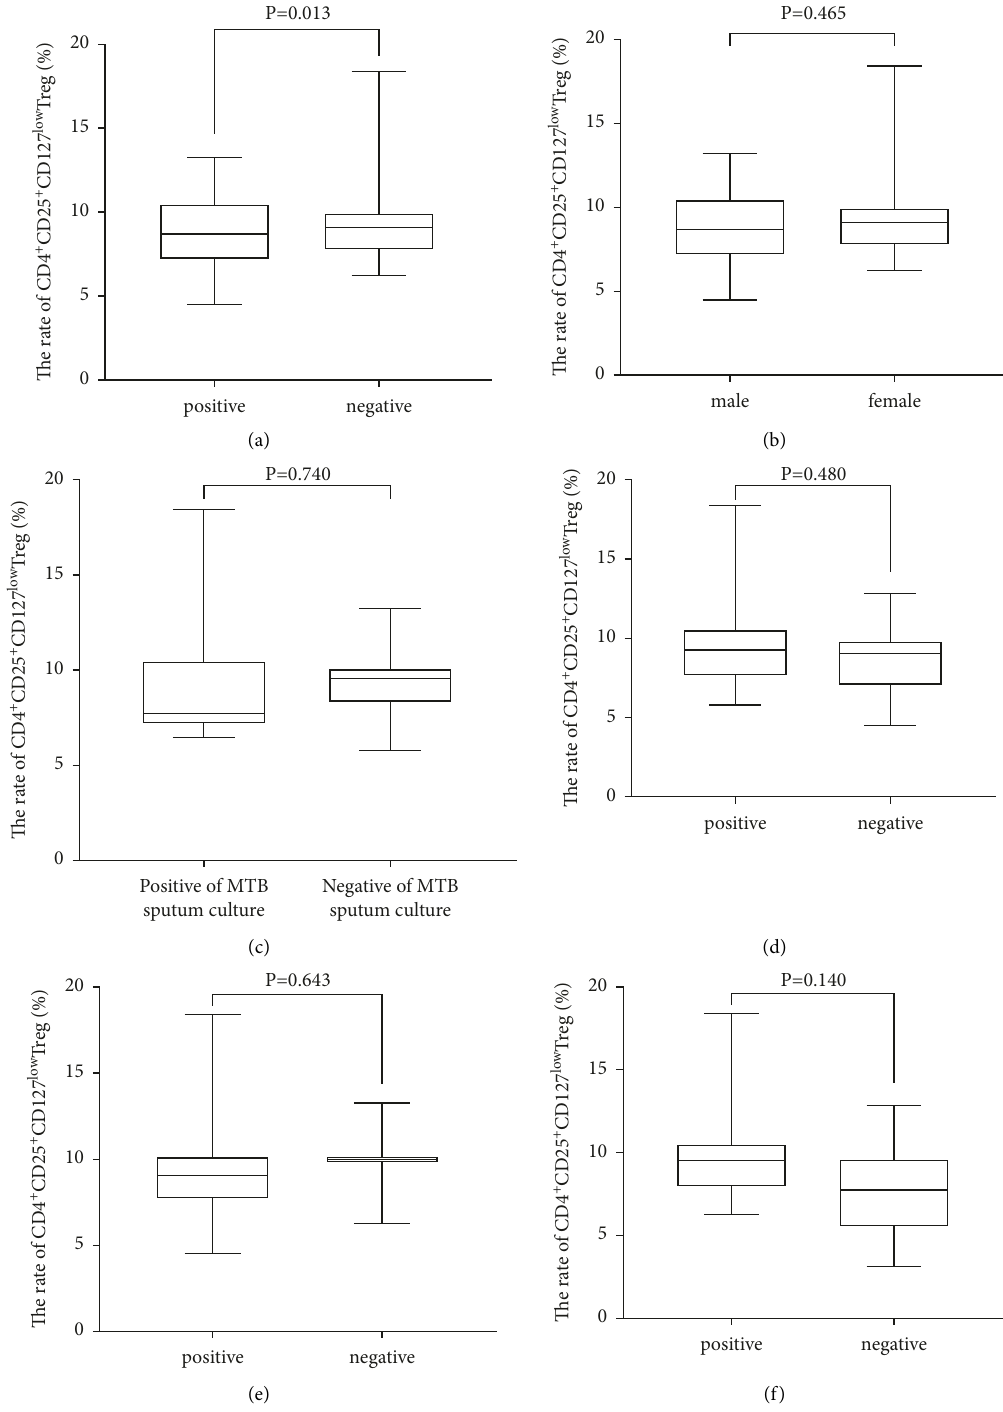
Figure 2: Proportions of peripheral blood CD4 + CD25 + CD127 low Tregs among active pulmonary tuberculosis patients with different demographic and clinical characteristics. (a) Comparison of the proportion of peripheral blood CD4 + CD25 + CD127 low Tregs between active pulmonary tuberculosis patients with positive and negative anti- M. tuberculosis antibodies. (b) Comparison of the proportion of peripheral blood CD4 + CD25 + CD127 low Tregs between male and female active pulmonary tuberculosis patients. (c) Comparison of the proportion of peripheral blood CD4 + CD25 + CD127 low Tregs between active pulmonary tuberculosis patients with positive and negative M. tuberculosis culture . (d) Comparison of the proportion of peripheral blood CD4 + CD25 + CD127 low Tregs between active pulmonary tuberculosis patients with positive and negative tuberculin tests. (e) Comparison of the proportion of peripheral blood CD4 + CD25 + CD127 low Tregs between active pulmonary tuberculosis patients with mild and severe CT examinations. (f) Comparison of the proportion of peripheral blood CD4 + CD25 + CD127 low Tregs between active pulmonary tuberculosis patients with positive and negative sputum smear